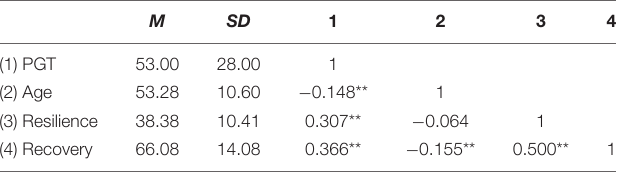
TABLE 2 | Correlations of PTG, age, resilience, and recovery.